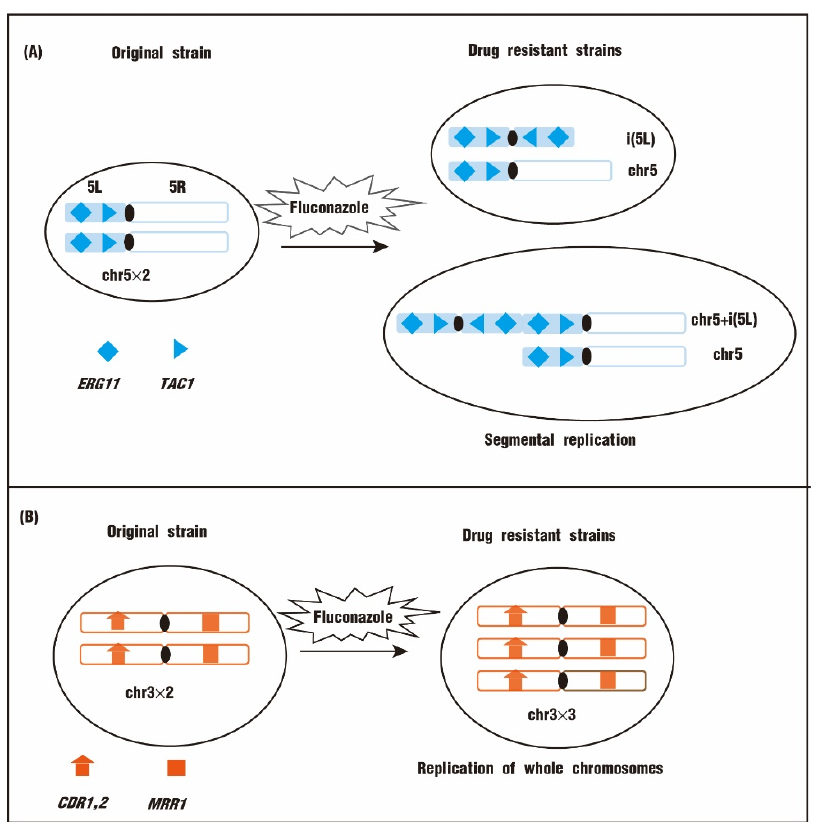
Figure 2. The aneuploidy-mediated fluconazole resistance. ( A ) The segmental aneuploidy i(5L) is related to fluconazole resistance in yeast. ( B ) The trisomy of chr3 is related to fluconazole resistance. Trisomy is also prevalent in fluconazole-resistant Candida species. In fluconazole-resistant C. albicans isolates, chromosome 4 (chr4) trisomy is identified, on which there are no mutations in resistance-associated genes [24]. Trisomy of chromosome 3 (chr3), chro- mosome 6 (chr6), and chromosome 7 (chr7) is also detected in fluconazole-resistant iso-